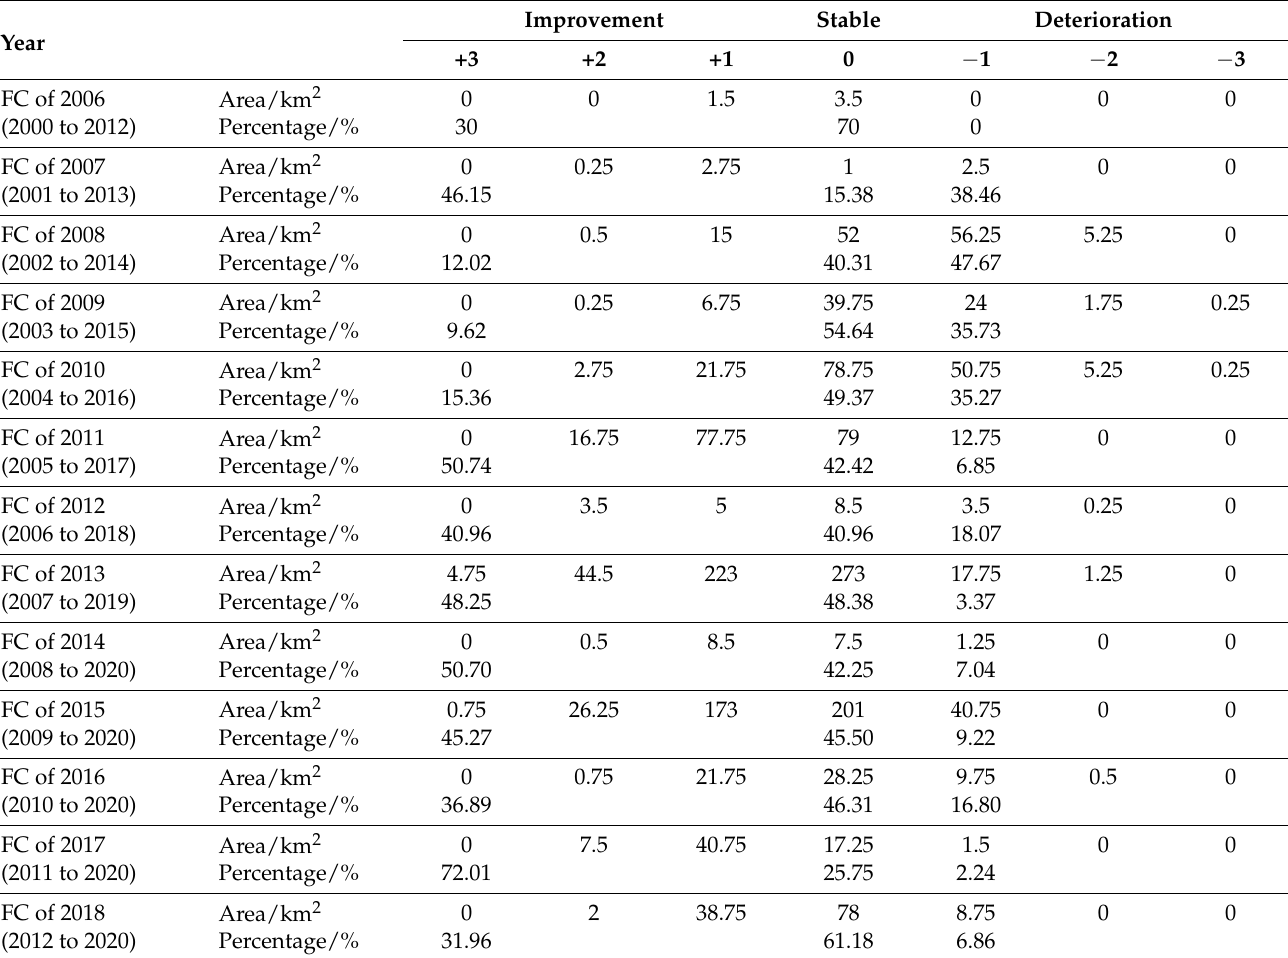
Table 2. Changes in RSEI levels in each FC phase based on the change vector